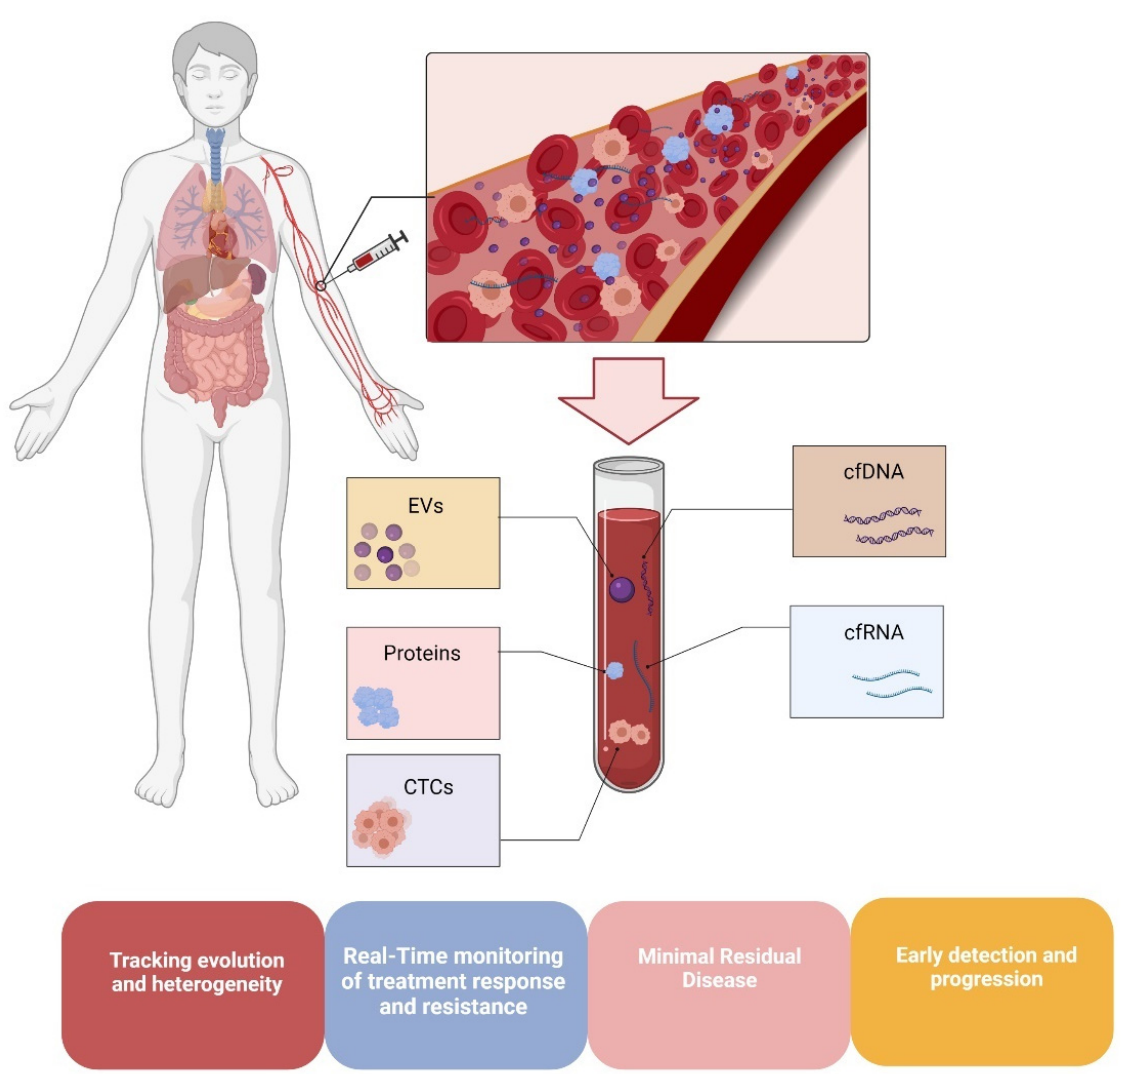
Figure 3. Liquid biopsy in cancer patients. Circulating tumor cells (CTCs), circulating cell-free tumor DNA (ctDNA), circulating cell-free RNA (cfRNA), and extracellular vesicles (EVs) can be isolated simultaneously from the same blood sample. Their analysis provides real-time information on tumor progression, minimal residual disease, treatment response, and resistance. Abbreviations: CTCs, circulating tumor cells; ctDNA, circulating cell-free tumor DNA; cfRNA, cell-free circulating RNA; EVs, extracellular vesicles. Diagram created by means of Biorender (https://biorender.com/ (accession date 8 October 2021)).